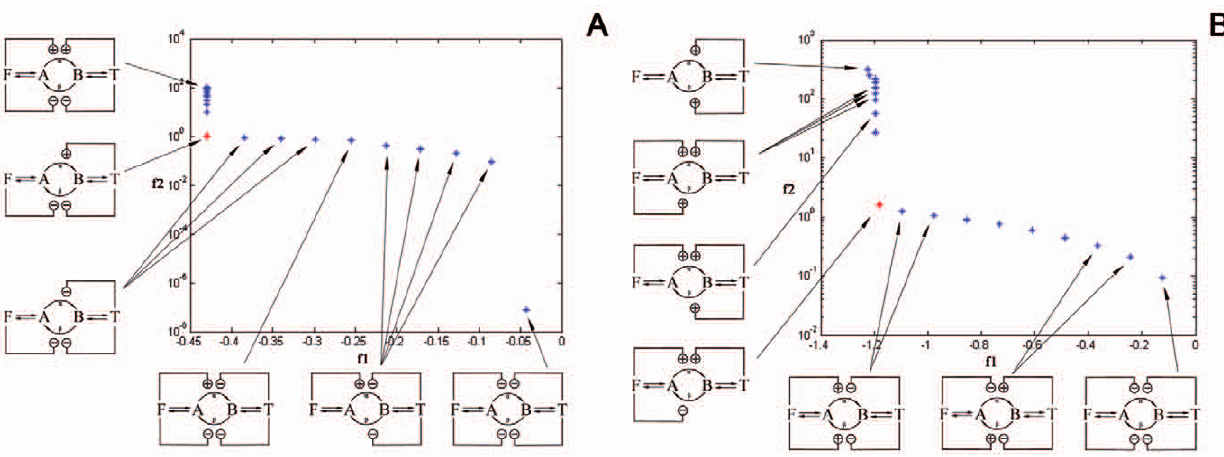
Figure 5. Semi log plots of the Pareto fronts for courses c (A) and d (B). Each point in the front corresponds to an optimal solution for f 1 and f 2 given by the estimated set of the eight control parameters. The small diagrams represent the corresponding regulation schemes deduced from each set of parameters. The red point corresponds to the knee point.